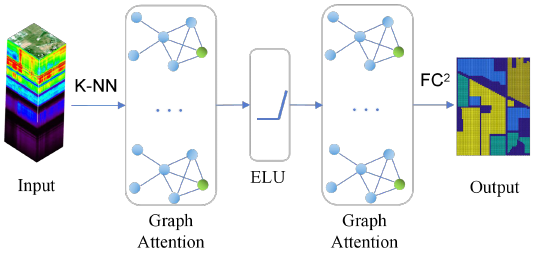
Figure 4 . Flowchart of the designed graph attention network.